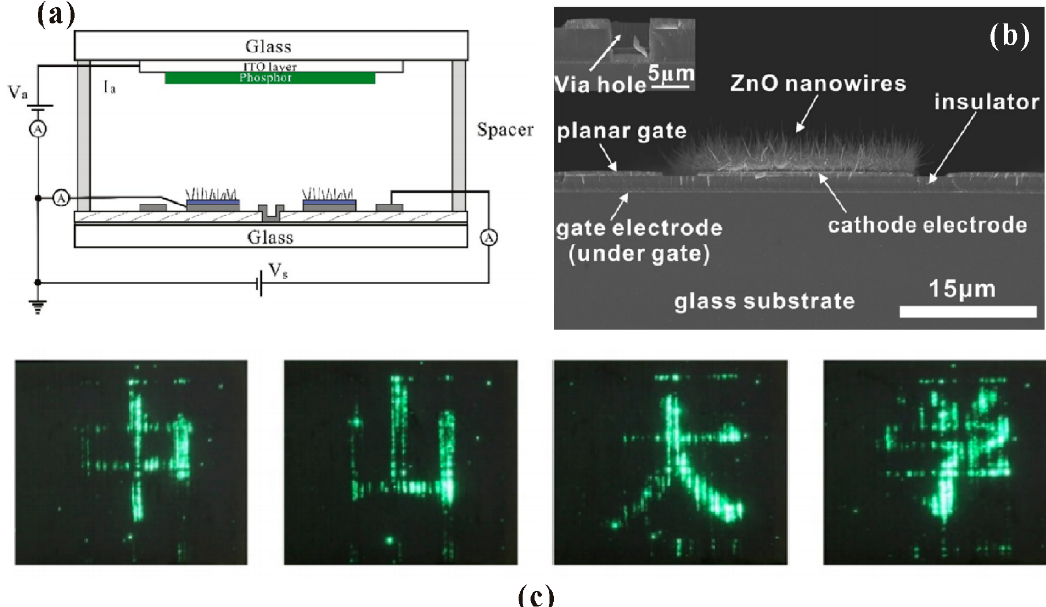
Figure 4. Demonstration of an addressable field emission device based on thermal oxidized ZnO nanowires. ( a ) Schematic diagram and ( b ) cross-sectional SEM image of the device. ( c ) Some Chinese characters displayed by the device. Reproduced from [34], with the permission of Elsevier, 2017.